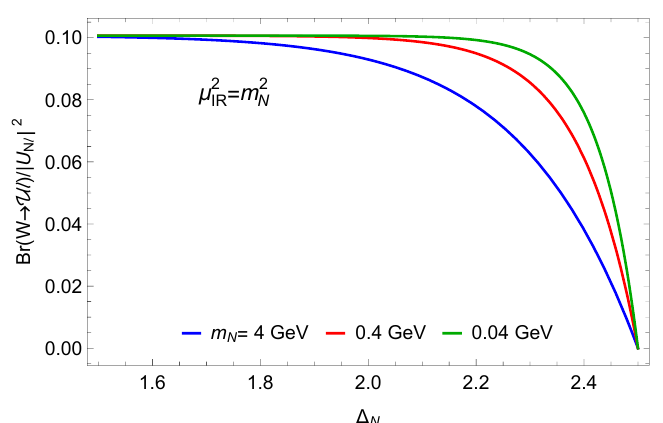
Figure 5 . The branching fraction of W → ‘ U , normalized by the IR mixing angle P benchmark choices of m